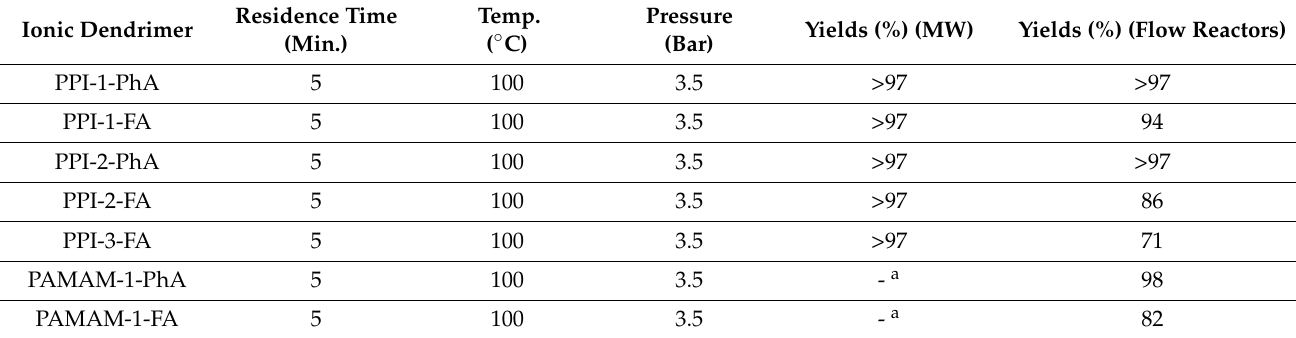
Table 3. Synthesis of ionic dendrimers in MW and flow